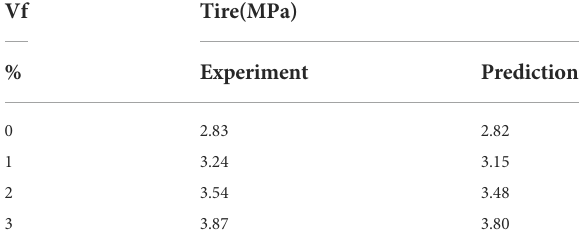
TABLE 3 Experimental and predicted splitting tensile